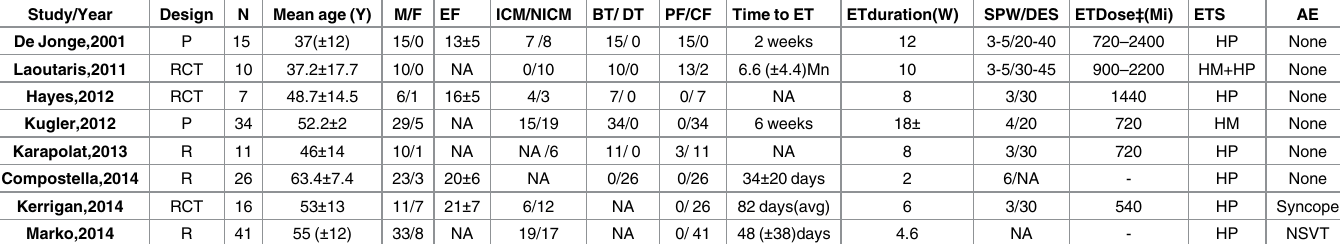
Table 1. Description of the ET group characteristics from the included